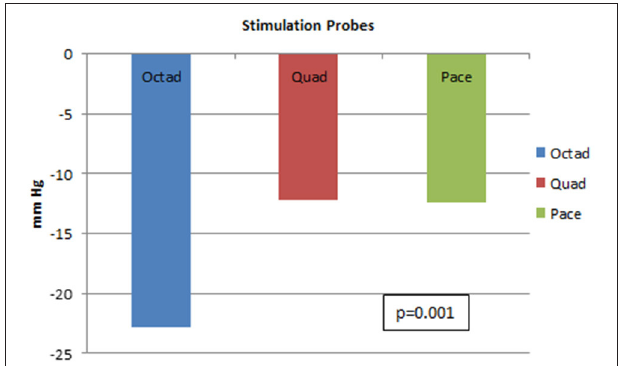
FIGURE 7 | Systolic blood pressure lowering for three different stimulation probes. This figure shows the systolic blood pressure lowering for the Octad, Quad, and Pace probes. There is superiority of the Octad probe in lowering blood pressure ( p -value =